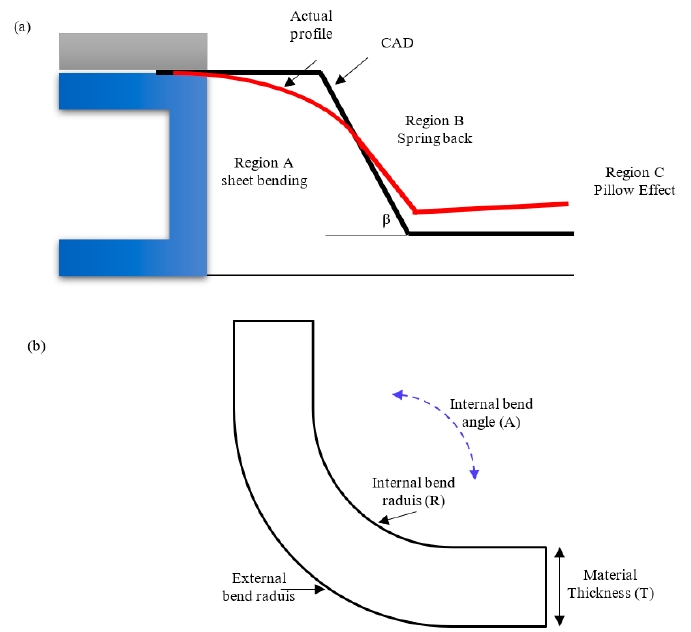
Figure 5. ( a ) A schematic diagram of the actual and ideal geometries. ( b ) Sheet metal parameters. To assess the part quality in the fifteen simulation trials, the maximum error in each of the three regions was measured, see Figure 6. It was found that the maximum geometrical deviation in region A was about 4.70 mm for all simulation scenarios, which did not improve compared to the single stage (4.67 mm). There was a significant variation in the error values in region B, which ranged from 1.04 to 4.75 mm. The maximum geometrical deviation in region C varied from 0.7688 to 2.6546 mm. In conclusion, the second forming stage improved the geometric accuracy in regions B and C while not deteriorating in region